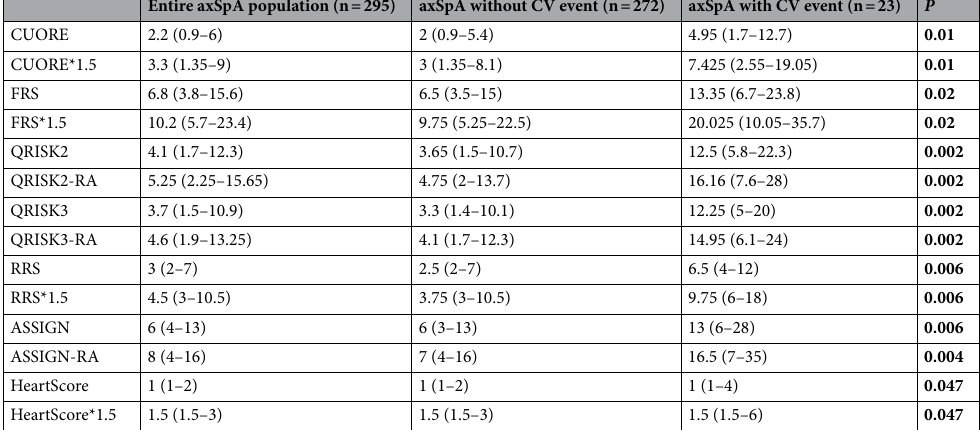
Table 2. CV risk algorithms of the patients with axSpA. axSpA axial spondyloarthritis; FRS Framigham risk score; RA rheumatoid arthritis; RRS Reynolds risk score; Score Systematic Coronary Risk